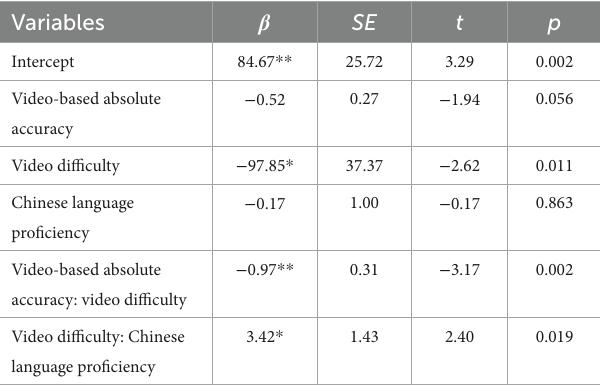
TABLE 2 Multiple regression of audiovisual comprehension performance based on video-based absolute